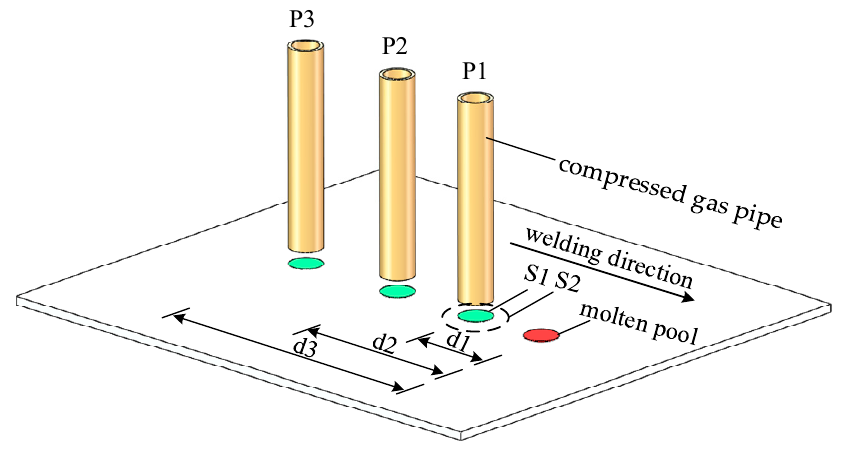
Figure 2. Principal model of the aerodynamic load application.